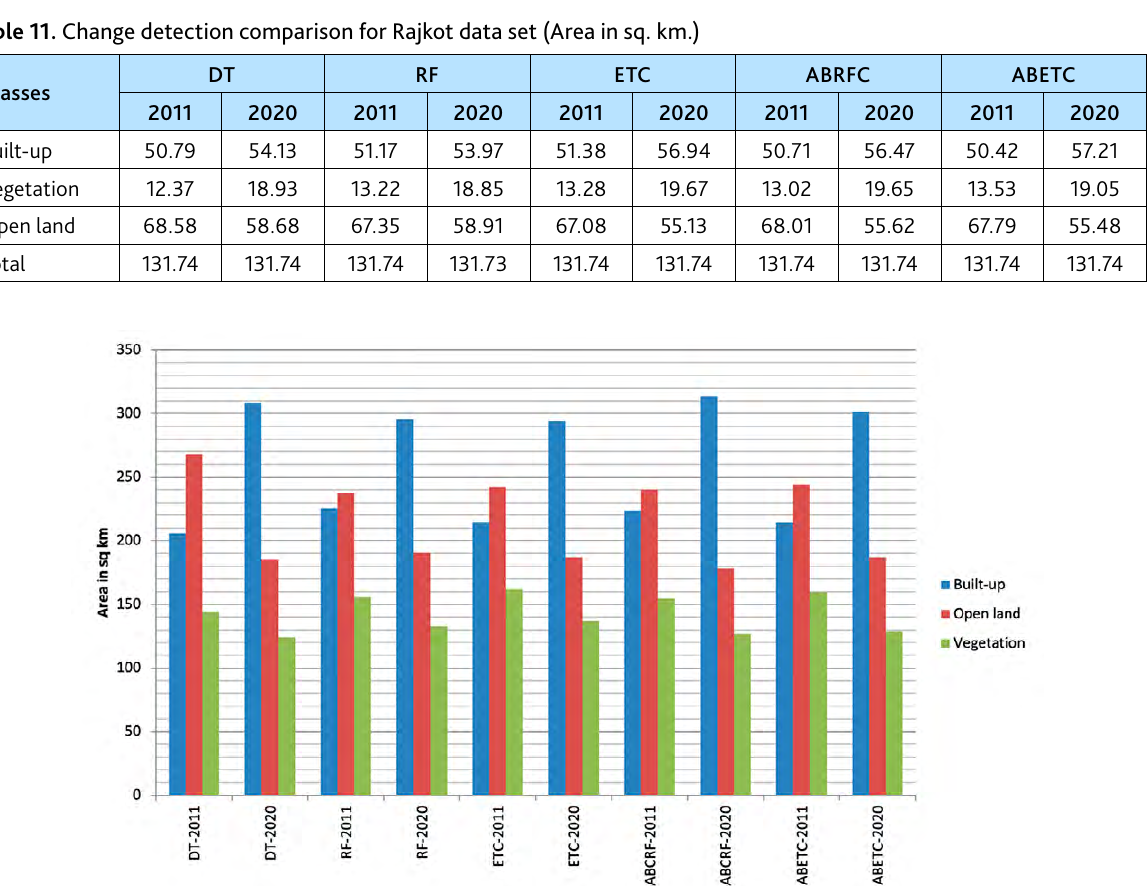
Figure 8. Area comparison graph of Ahmedabad data er algorithms for the Ahmedabad, Vadodara, and Ra- sifier were used for change detection analysis (Table jkot data sets. The object based integrated AdaBoosted 6-8) and change map generation. The rise in a built- extra trees classifier (ABETC) has demonstrated the up area for Ahmedabad was found higher compared highest performance in terms of OA and KC for all to the Vadodara and Rajkot data set with a significant the data sets. The results of this highly efficient clas- fall off of vegetation class.